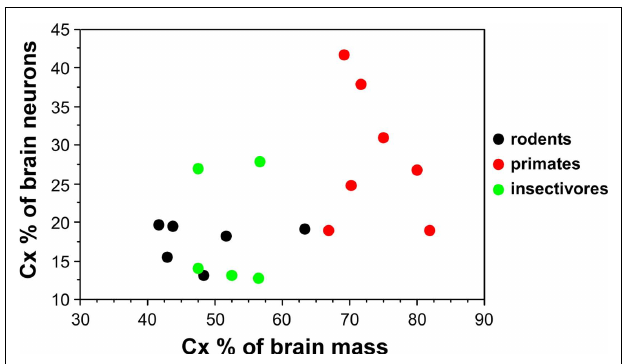
FIGURE 2 | Relative size of the cerebral cortex does not inform about the relative number of neurons in the cortex compared to the whole brain. Each point indicates, for a given species, the average relative cortical mass as a percentage of total brain mass (X-axis) and the average relative number of cortical neurons as a percentage of the total number of neurons in the brain (Y-axis). Data from Herculano-Houzel et al. (2006, 2007); Azevedo et al. (2009); and Sarko et al.